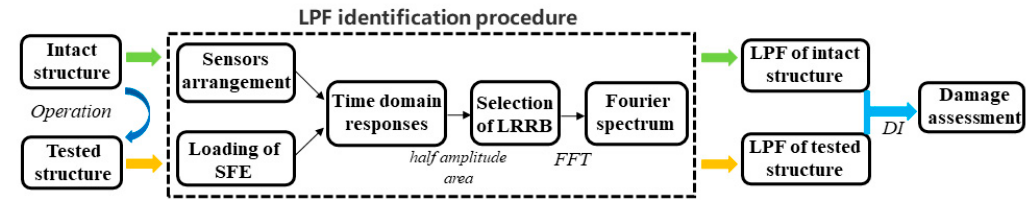
Figure 4. Flowchart of the proposed method.